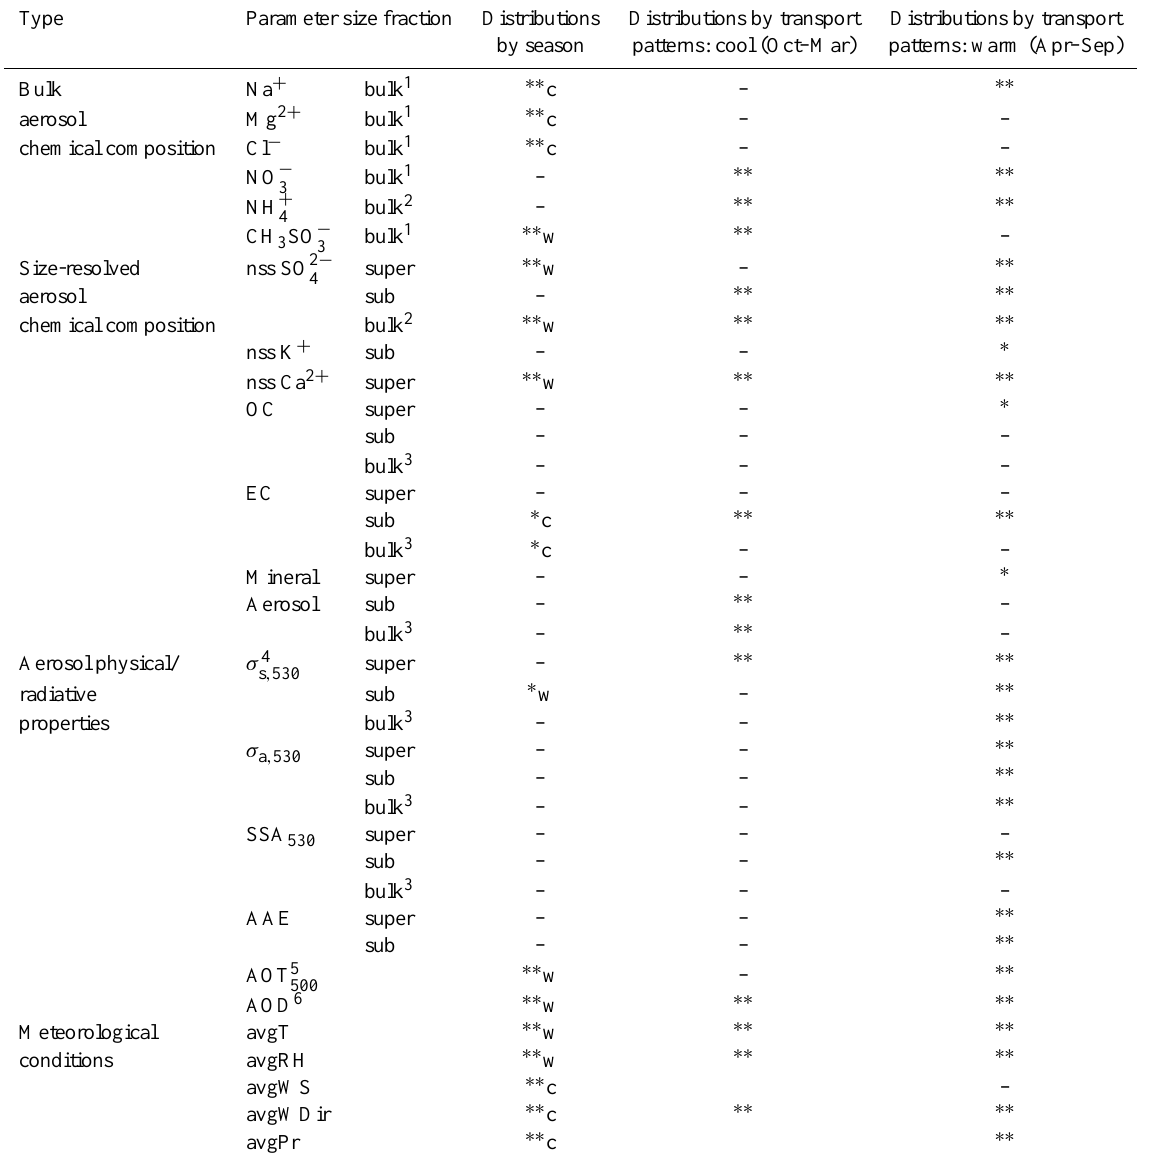
Table 2. Results of non-parametric statistical tests on distributions of aerosol composition, radiative characteristics, and meteorological conditions during sampling, compared across season, and between flow patterns within each